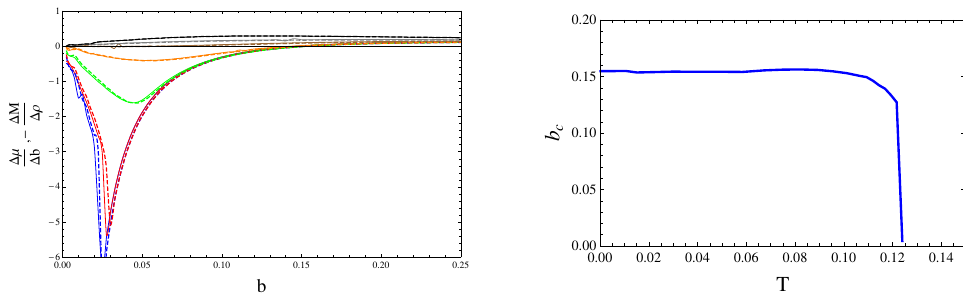
Figure 12 . Left panel: the ratios (cid:1) (cid:22)= (cid:1) b (solid lines) and (cid:0) (cid:1) M= (cid:1) (cid:26) (dashed lines) plotted as functions of the magnetic (cid:12)eld b for seven di(cid:11)erent values of the temperature v T = 0 (blue), v T = 0 : 02 (red), v T = 0 : 1 (green), v T = 0 : 2 (orange), v T = 0 : 3 (brown), v T = 0 : 36 (gray) and v T = 0 : 4 (black). Right panel: critical magnetic (cid:12)eld b c where IMC becomes MC as a function of the temperature T . Below b c the chemical potential (cid:22) decreases with b (IMC) whereas above b c one (cid:12)nds the opposite behaviour